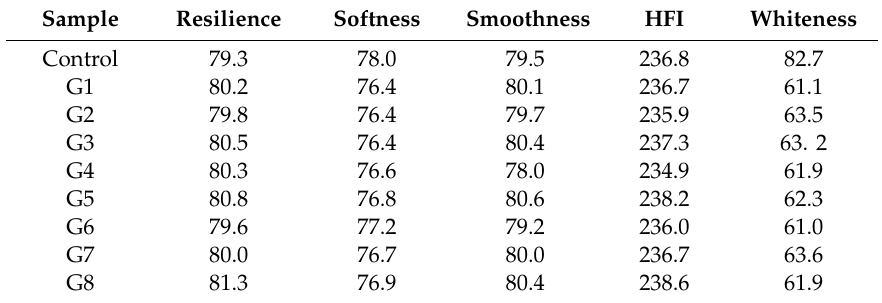
Table 7. The hand feel properties of PHMB coated fabric samples after washing (104 cycles, 65 ◦ C).